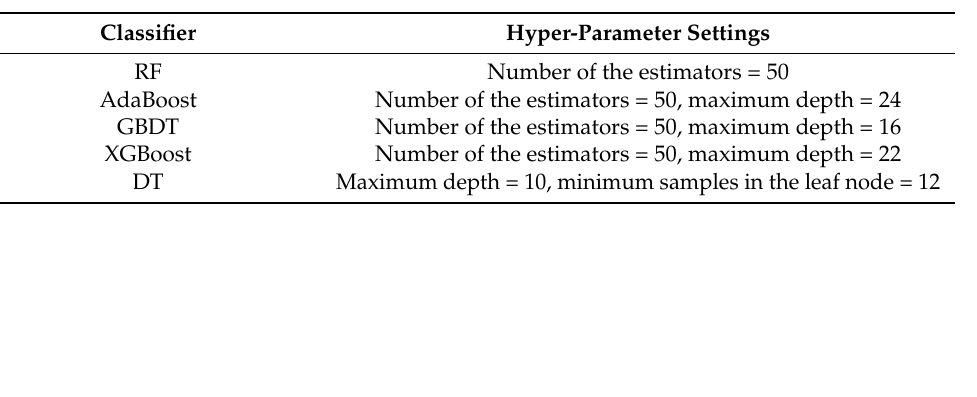
Table 3. Hyper-parameter settings for the ER